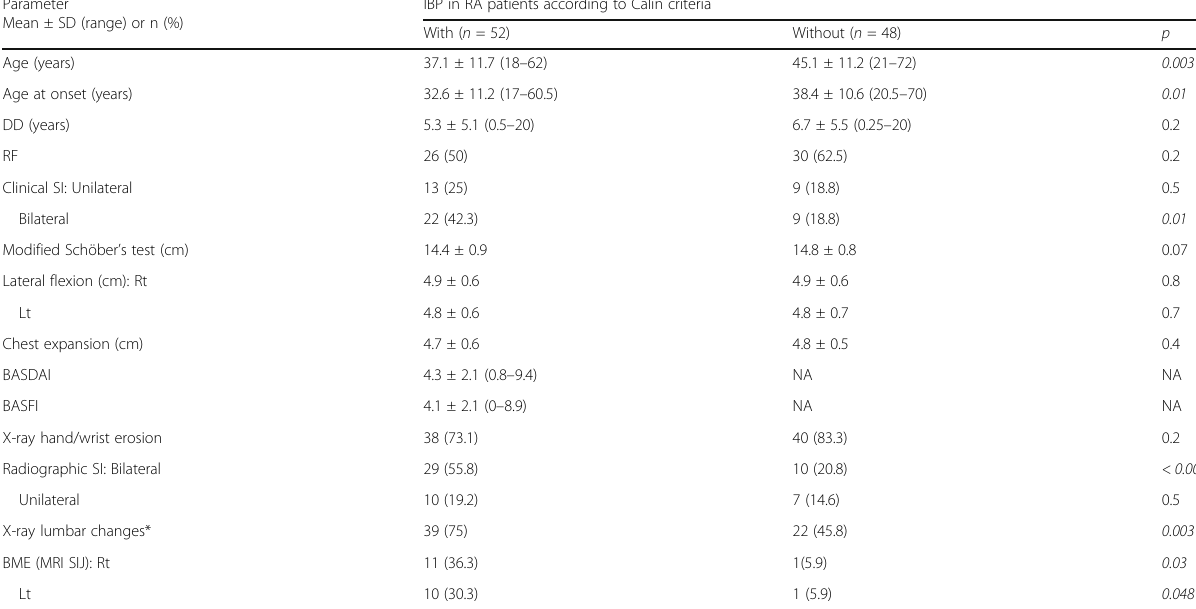
IBP in RA patients according to Calin criteria